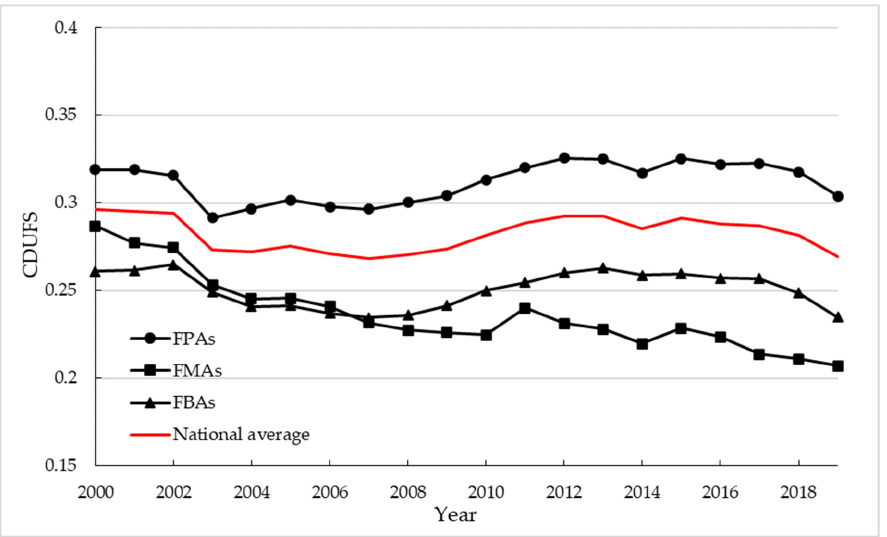
Figure 2. Time variation of CDUFS in different food functional areas. Note: This figure is drawn by the authors themselves based on the calculation results. the authors themselves based on the calculation Table 2. Moran’s I of the CDUFS.